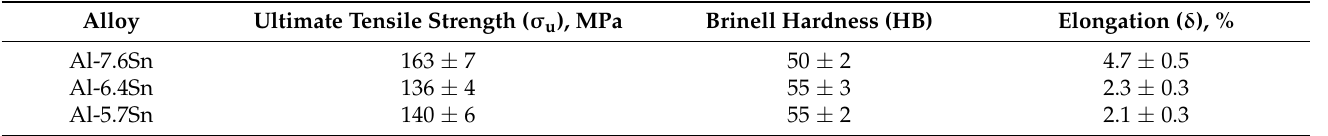
Table 3. Mechanical characteristics of the selected alloys.